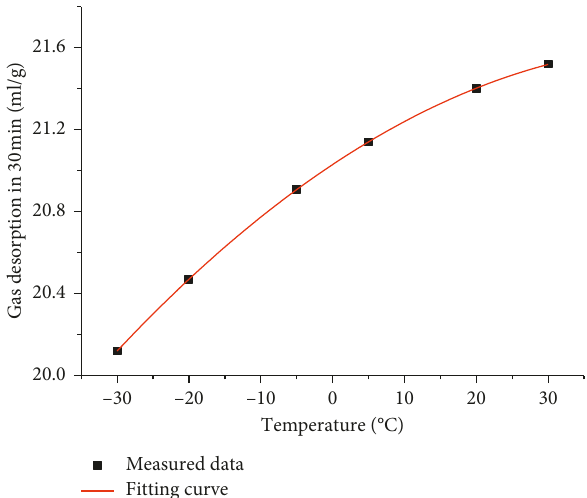
Figure 5: Curve of the gas desorption amount per unit mass in 30min versus the